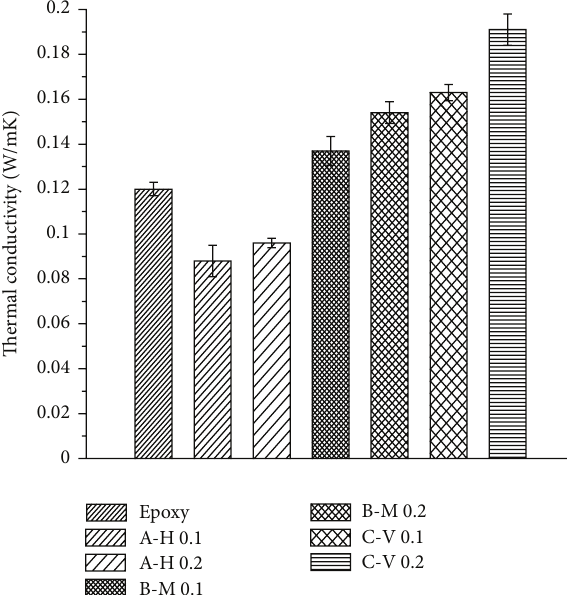
Figure 5: Thermal conductivity of